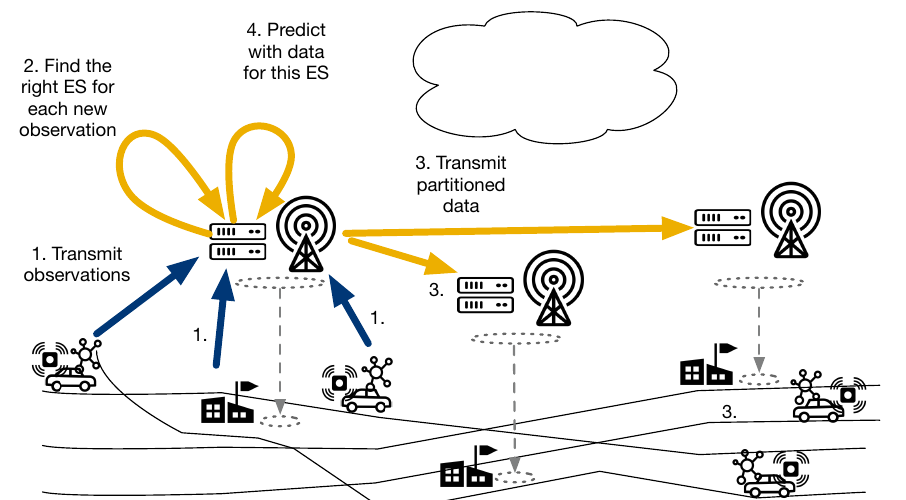
Figure 4. EDISON distributed inference. Edge servers partition newly-observed data, transmit the partitions to their designated edge servers, and use the local new data for interpolation.